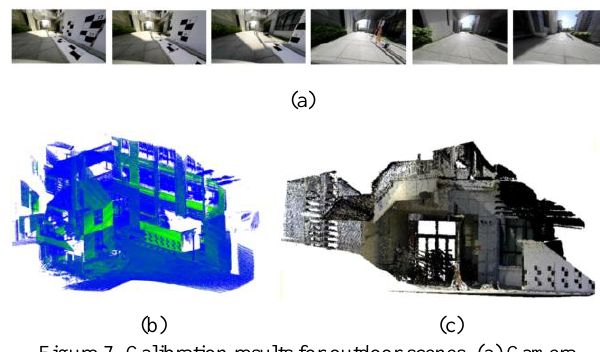
Figure 7. Calibration results for outdoor scenes. (a) Camera images. (b) Point clouds. (c) Fusion result.